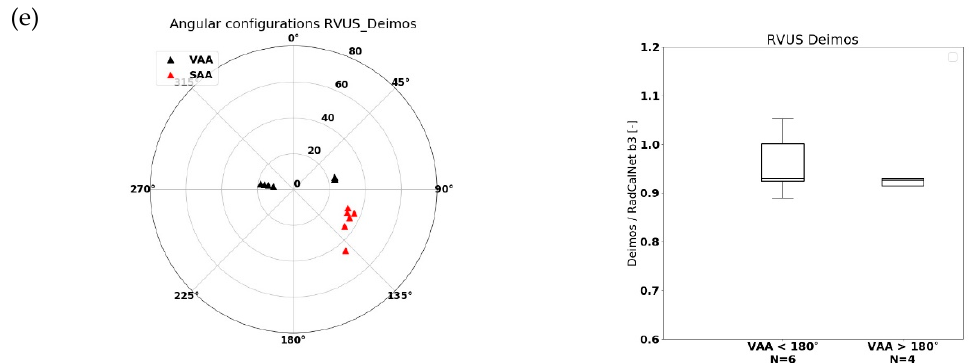
Figure 6. Similar to Figure 4, but for RVUS. Note that over this site subfigure ( e ), containing results for Deimos-1, is included.